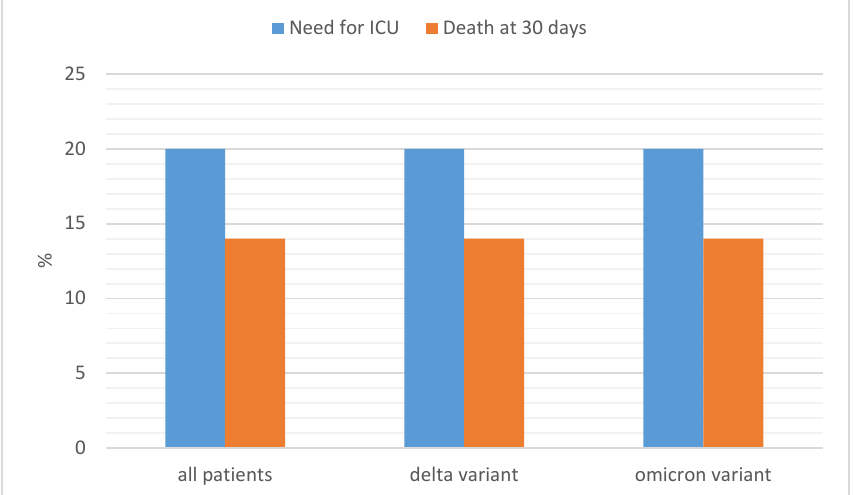
Figure 1. Need for intensive care unit (ICU) admission and all ‐ cause 30 ‐ day mortality by virus variant.